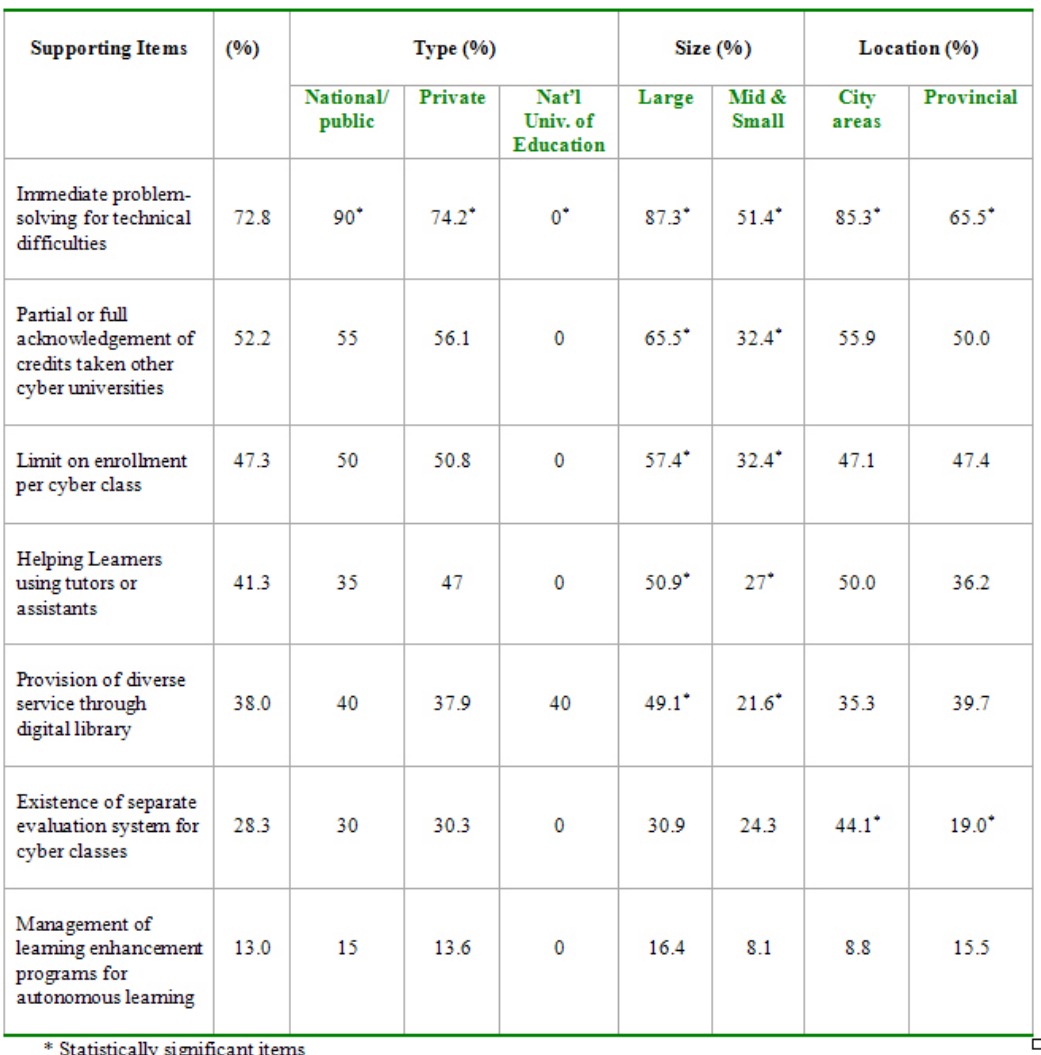
Table 4. State of Learner Support for